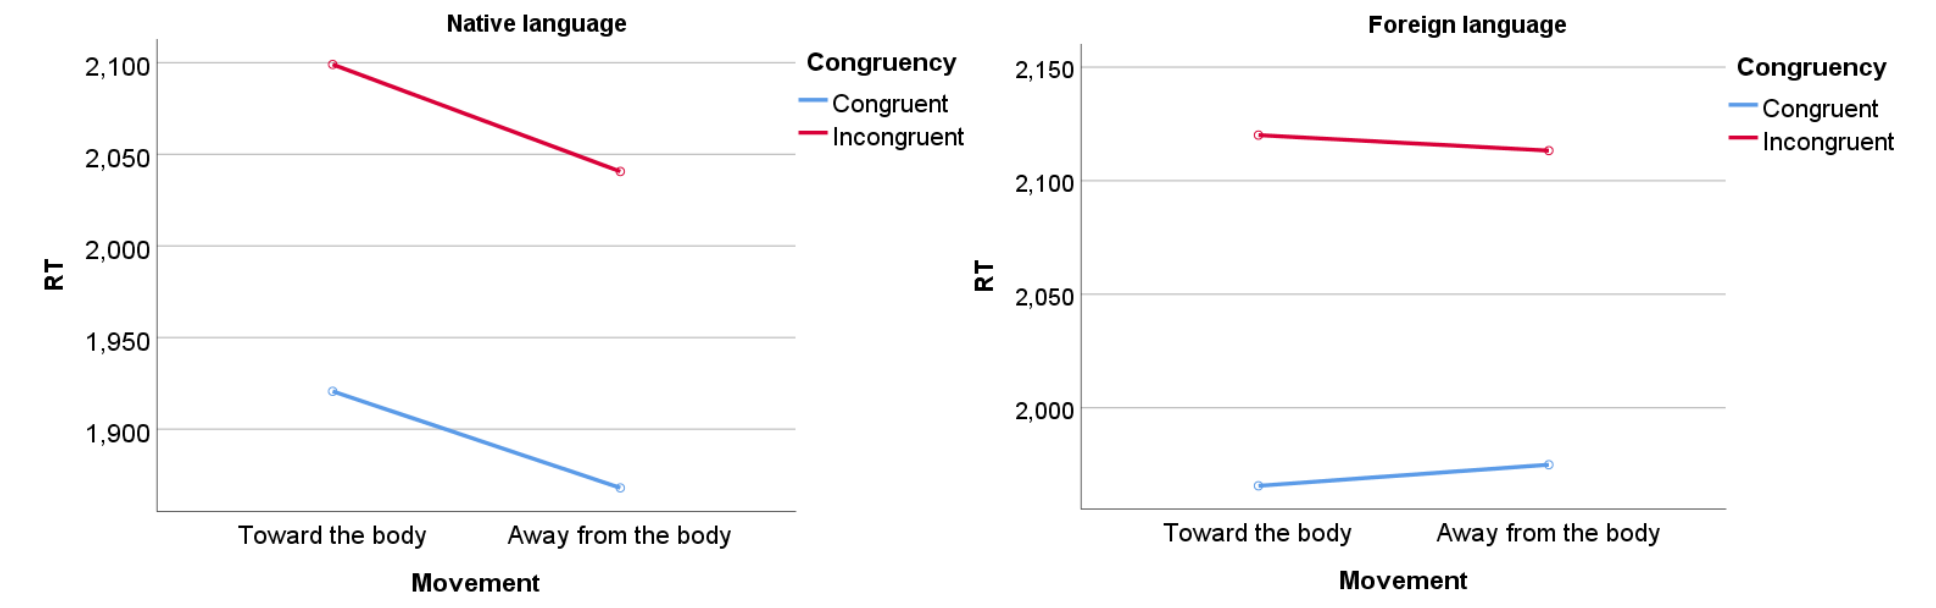
Figure 1 - RT for verbs in native and foreign language DOI: